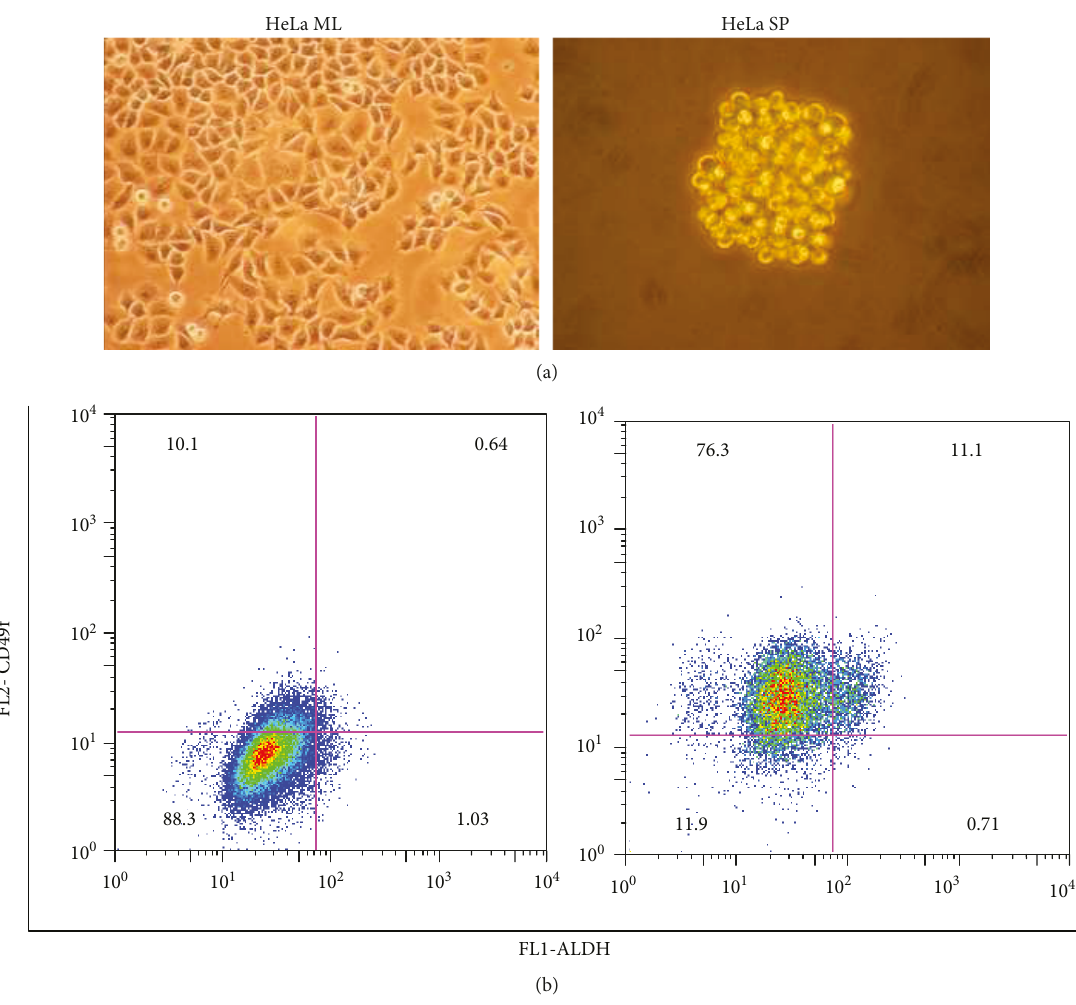
Figure 1: HeLa SP are positive for cancer stem cell markers. (a) Microscopy of cultures derived from the HeLa cell line growing as monolayer (HeLa ML) and as spheres (HeLa SP), objectives 20x and 40x, respectively. (b) Flow cytometry analysis of HeLa ML and HeLa SP cultures for CD49f and high ALDH activity, with the gates representing the percentage of cell populations positive for staining. For HeLa SP, 87% of cells were positive for CD49f, nearly 12% were positive for high ALDH activity, and for both markers, 11% were positive. In HeLa ML, 88% of cells were negative for both markers, while less than 1% were positive for the